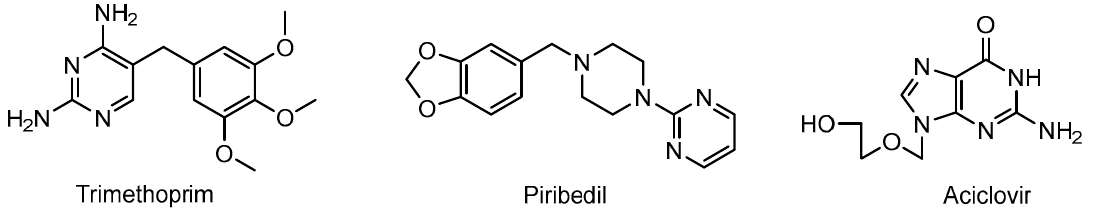
Figure 1. Structures of some medicines containing a pyrimidine moiety.